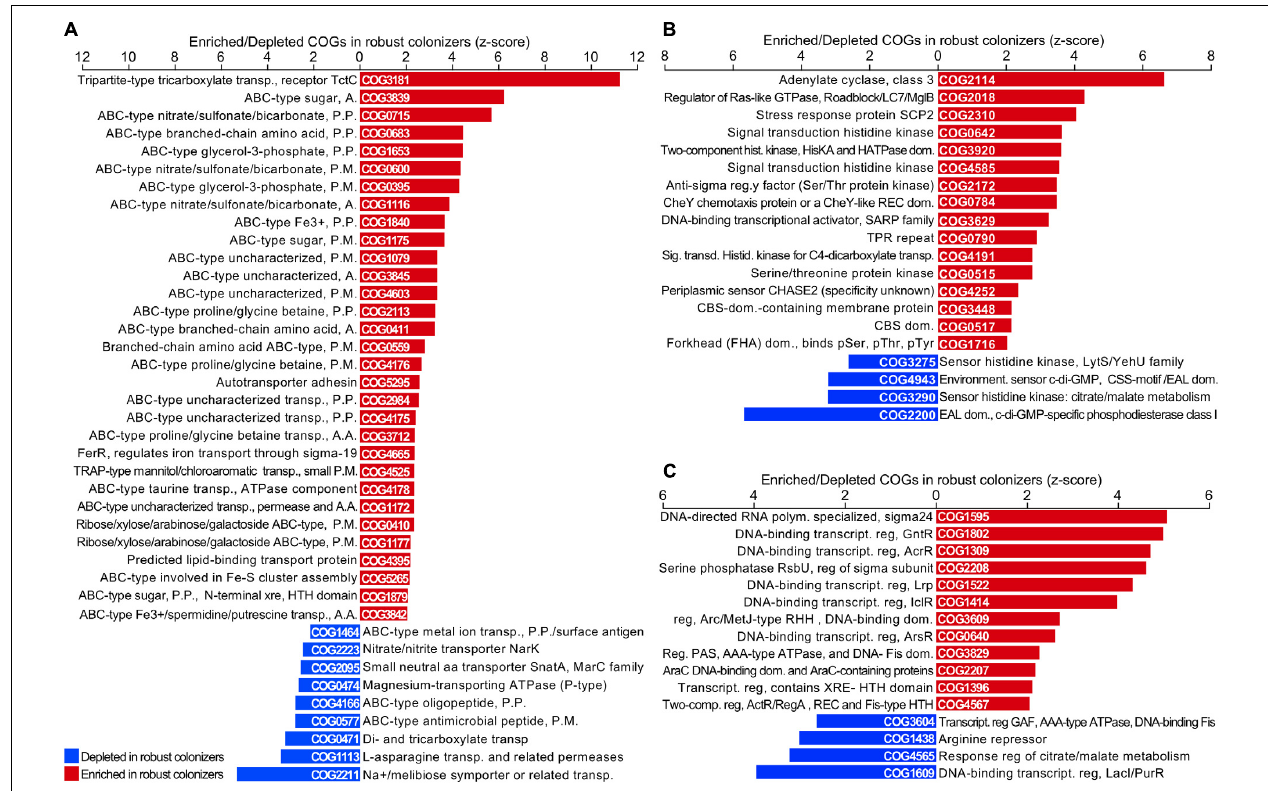
FIGURE 6 | Enrichment and depletion of COGs associated to transporters (A) signal transduction mechanisms (B) and transcription (C) in robust colonizers. Only COGs significantly enriched or depleted are displayed ( P < 0.05). Original COG IDs were maintained and names were shortened when